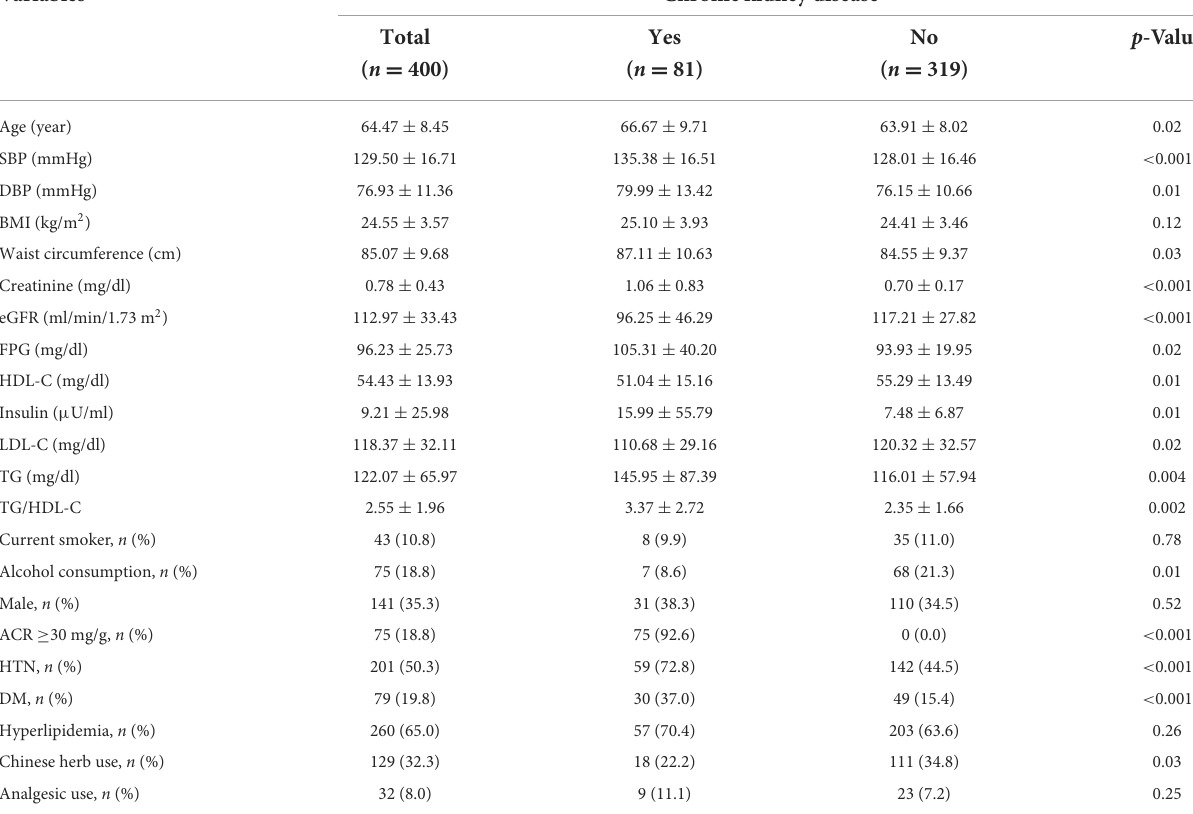
TABLE 1 General characteristics of the study population according to the presence of chronic kidney disease (CKD). Variables